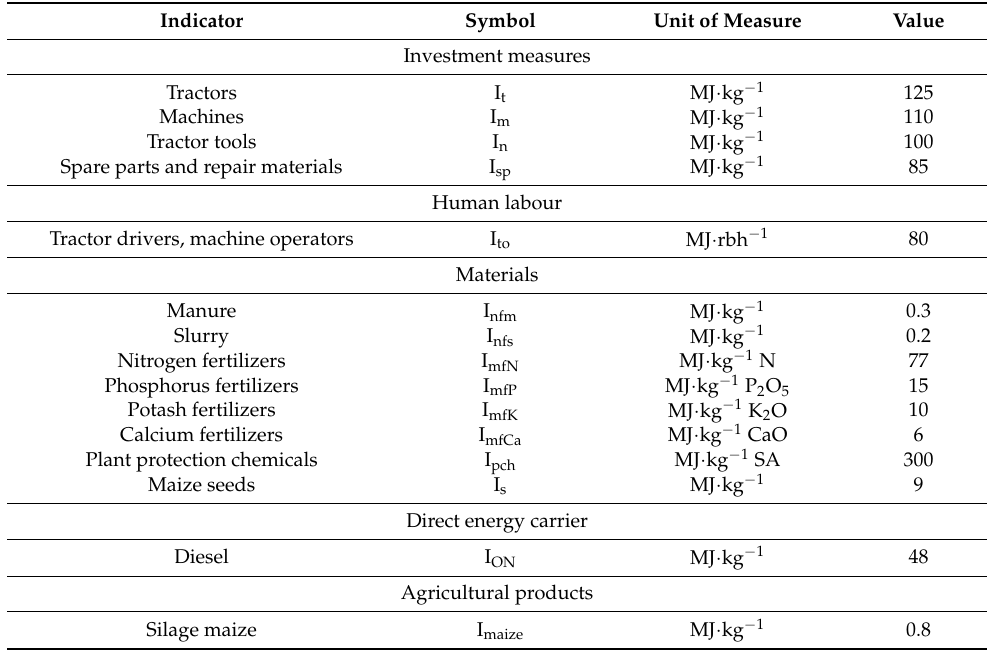
Table 4. Unitary energy consumption